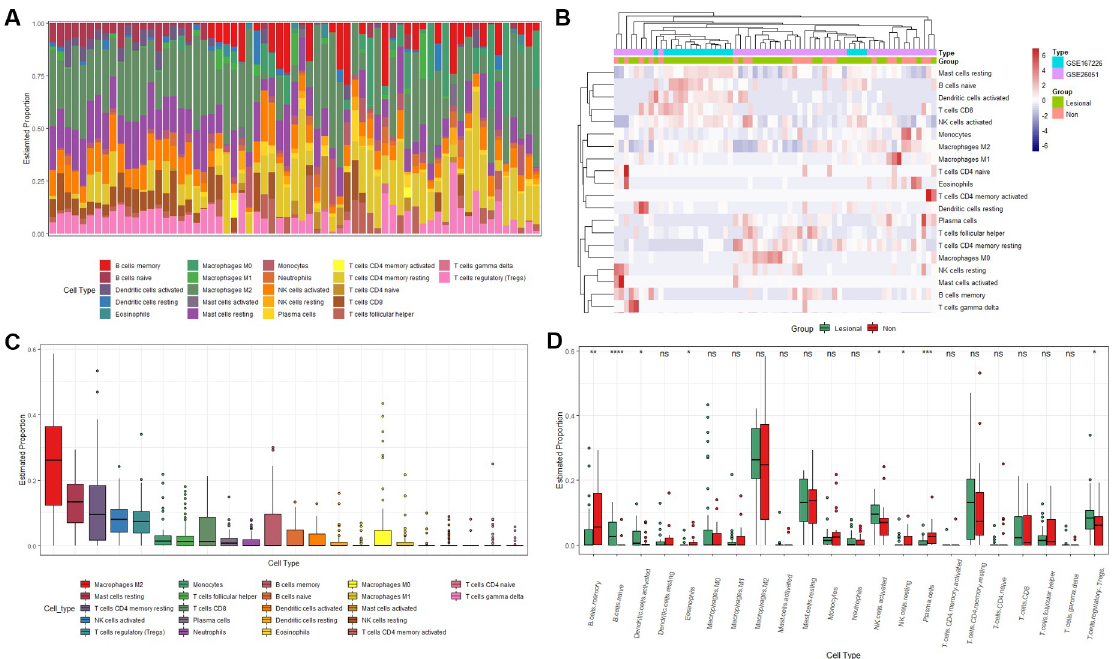
Fig 6. Infiltration patterns of immune cells in different groups. (A)Relative percentage of 22 immune cell subsets in tendon disease samples (B) Heat map of immune cell infiltration between tendinopathy group and control group, green represents tendinopathy group, red line represents control group (C) Infiltration degree of 22 immune cell subsets in tendon disease samples (D) Box Diagram of Immune Infiltration Difference between Tendon Disease Group and Control Group, Green as Tendon Disease Group, Red as Control Group.